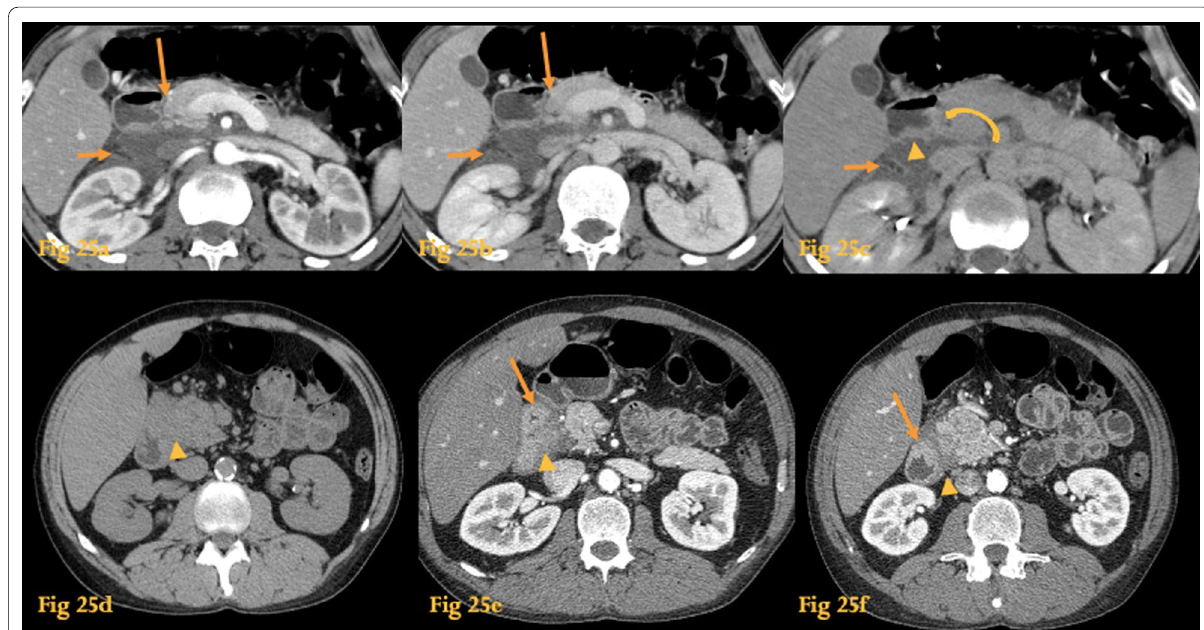
Fig. 25 Paraduodenal pancreatitis. Abdominal CT of a patient with clinical and laboratory findings suggestive of pancreatitis ( a – c ). The pancreas has normal volume, morphology, and texture. There is retroperitoneal fluid in the right anterior pararenal space (small arrows) and in the pancreatoduodenal groove (big arrows). The posterior wall of the descending duodenum is slightly thickened (arrowhead) and the pancreatoduodenal groove reveals discrete late enhancement (curved arrow on c ), suggestive of fibrotic changes. Abdominal CT of another patient